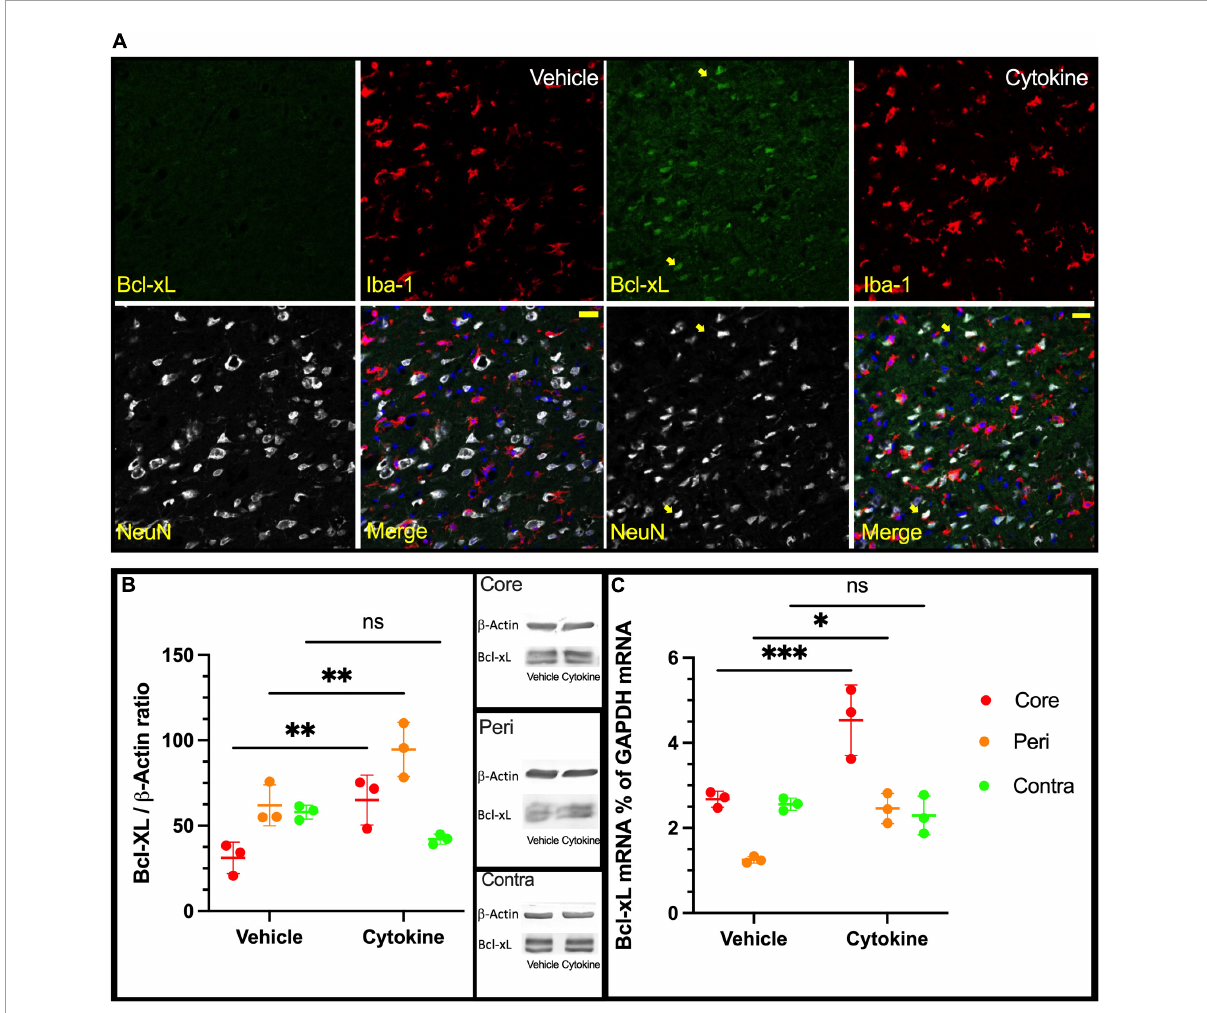
FIGURE3 Increased expression of Bcl-xL following cytokine (GM-CSF and IL-3) administration at 3 dpr. (A) Representative immunohistochemical data in which Bcl-xL is only faintly expressed in nerve cells of the vehicle-treated group. In the cytokine group, Bcl-xL is prominently expressed in many neurons as indicated by the yellow arrows, scale bar-50 µ m. (B) Expression of Bcl-xL protein in the core, peri, and contra regions at 3 dpr. (C) Expression of Bcl-xL-encoding mRNA at 3 dpr in core, peripheral, and contra tissues. Immunoblotting and qPCR data analyzed with ANOVA and are shown as means ± SD ( n = 3). ∗ P < 0.05, ∗∗ P < 0.01, ∗∗∗ P < 0.001 vs. vehicle of each group. GM-CSF, granulocyte macrophage colony-stimulating factor; IL, interleukin; dpr, days post-reperfusion; ANOVA, analysis of variance; SD, standard